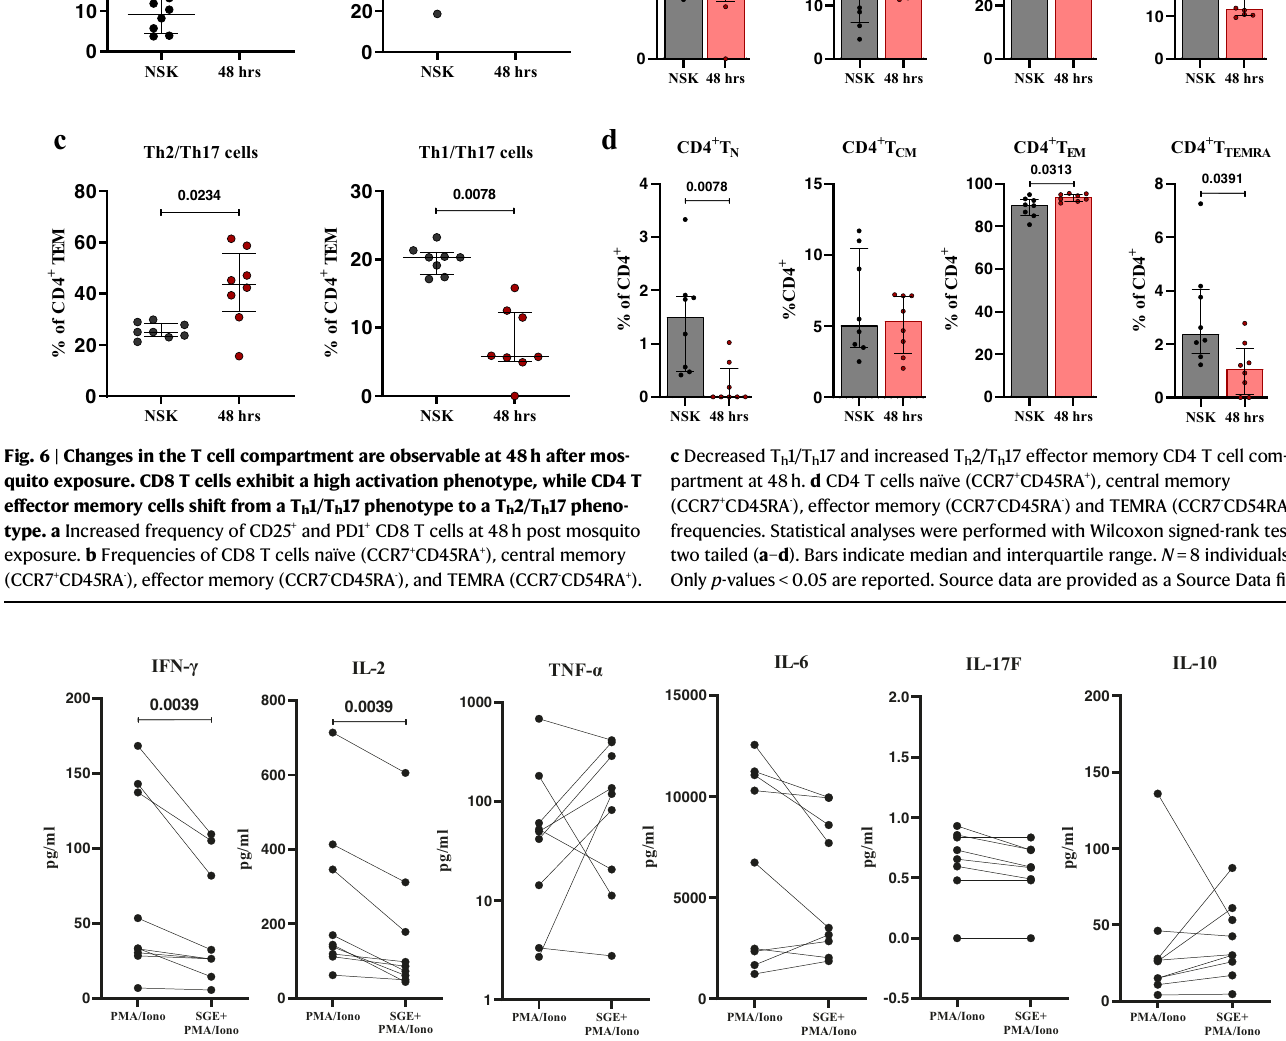
(50,000 cells/well) and treated with SGE (10 µ g/mL) or PBS for 24h. Cells were stimulated with PMA (0.1 µ g/mL) and Ionomycin (1 µ g/mL) or left unstimulated for the last 6h of the culture. Statisticalanalysis wasperformed with Wilcoxon signed- rank test, two tailed. N =9 individuals. Only p -values<0.05 are reported. Source data are provided as a Source Data fi le.